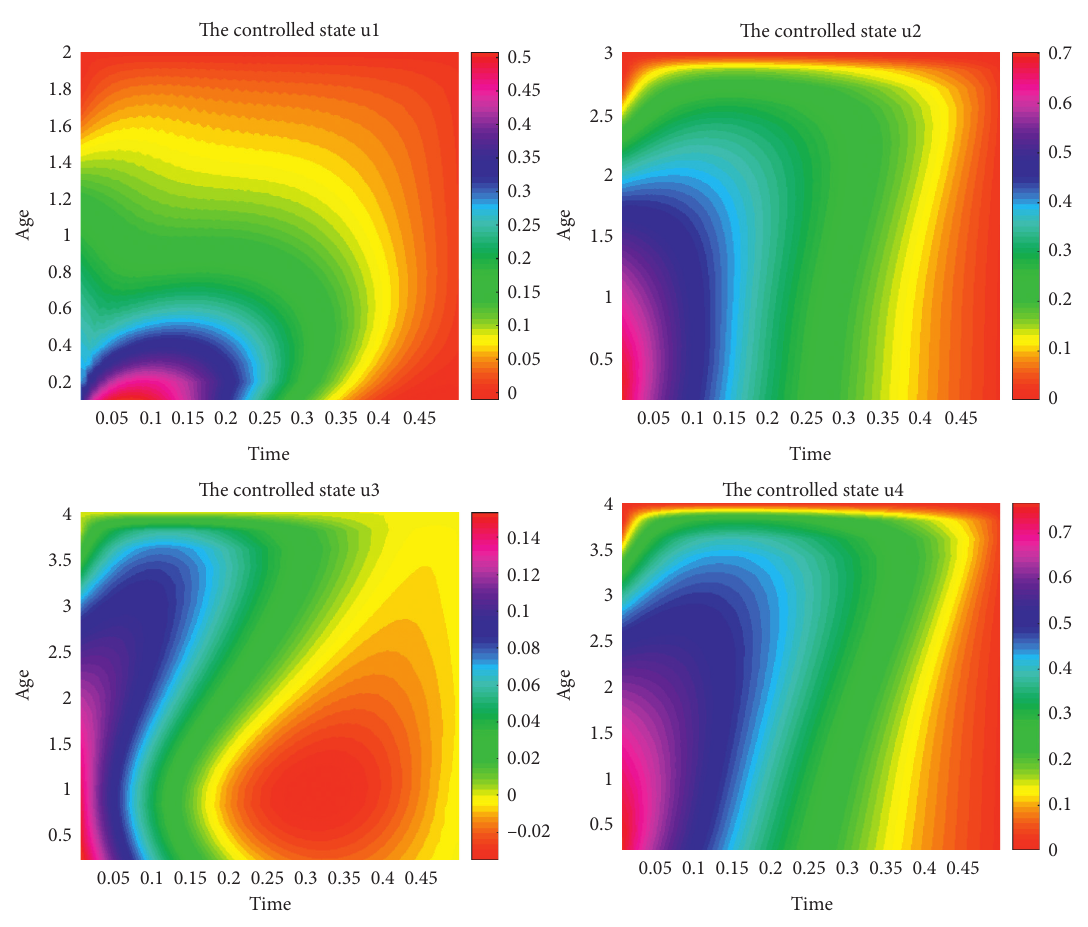
Figure 4: Controlled solution at final time T � 0 . 5 and A �